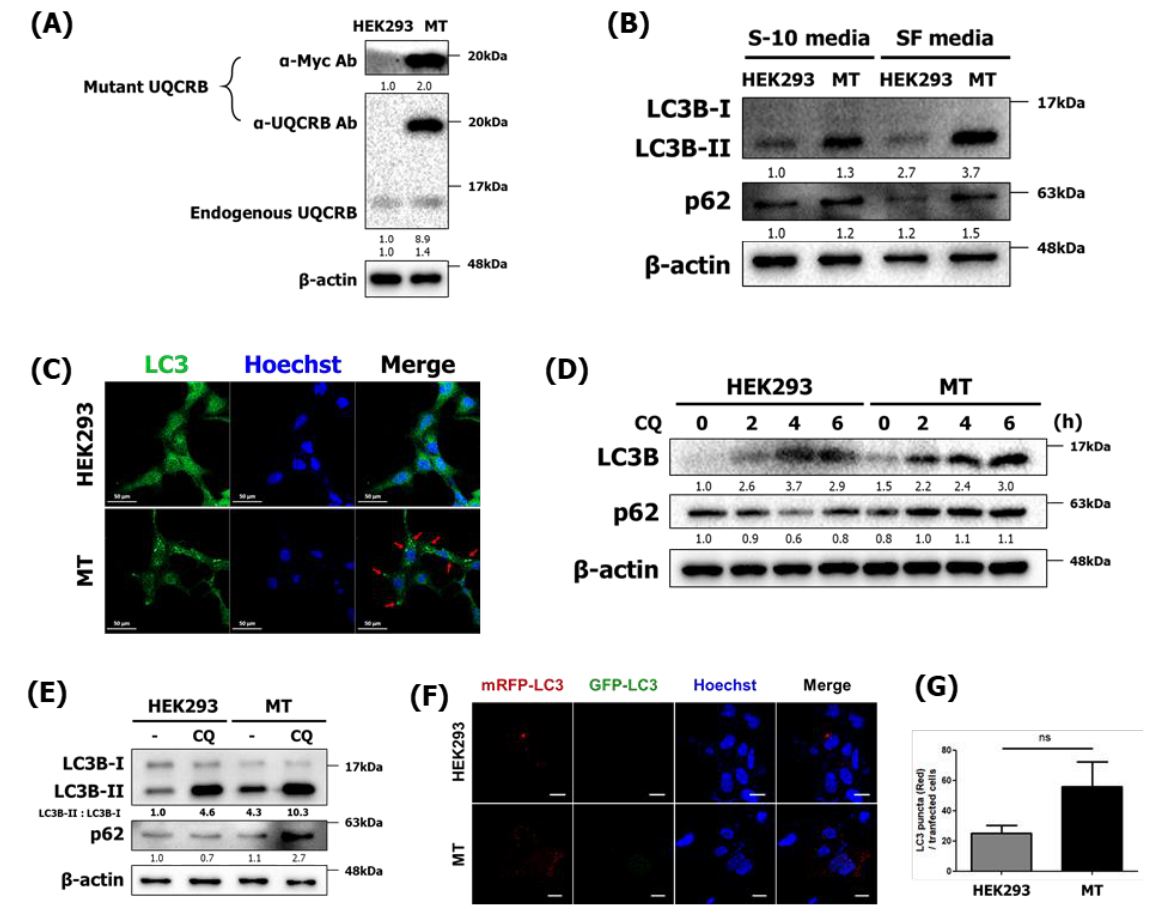
Figure 2. Autophagy is induced in MT cells. ( A ) Mutant UQCRB-expressing cell lines were examined by Western blotting using anti-UQCRB and anti-Myc antibodies. ( B ) HEK293 and MT cells treated with either 10% serum-containing medium or serum-free medium for 24 h and then analyzed by Western blot analysis using antibodies against LC3B and p62. Figure S4 shows treatment of either 10% serum-containing medium or serum-free medium for 4h.( C ) Confocal microscopy im- ages of HEK293 and MT cells treated with serum-free medium for 24 h after immunostaining with anti- LC3 antibody. Scale bar, 50 µm. ( D ) Western blot analysis results of LC3B and p62 levels in cells after treatment with 5 µM chloroquine (CQ) treatment for 0−6 h. ( E ) HEK293 and MT cells were treated with either deionized water (DIW) or CQ for 6 h. Cell extracts were subjected to Western blotting using LC3B and p62 antibodies. The densitometric value of LC3-II was quantitated based on Western blot data and normalized to LC3-I levels. ( F ) Confocal microscopy images of HEK293 and MT cells transfected with mRFP-GFP- LC3 for 24 h. Scale bar, 20 µm. ( G ) Numbers of mRFP- LC3 puncta were counted in HEK293 and MT cells ( n = 8). The relative band intensities value was normalized to β -actin (loading control). The normalized protein levels are shown under each band. Data are presented as the mean ± SD; statistical significance was assessed using an unpaired t -test. ns, p > 0.05. Next, we confirmed the presence of autophagy markers LC3 and p62 in MT cells us- ing immunoblotting. During autophagy, LC3-I is converted to LC3-II, which is a key com- ponent of autophagosomes. In ubiquitin-dependent autophagy, autophagic cargo recep- tor proteins such as p62 act as degradation substrates of the autophagic membrane so that p62 protein levels can be increased while autophagy occurs [21]. When treated with serum and starved, MT cells had higher LC3-II and p62 levels than normal HEK293 cells (Figure 2B). Next, autophagy induction was examined by immunocytochemistry using LC3 anti- bodies. HEK293 and MT cells were incubated in SF medium for 24 h, after which LC3 puncta were only observed in MT cells (Figure 2C). This result demonstrated that UQCRB